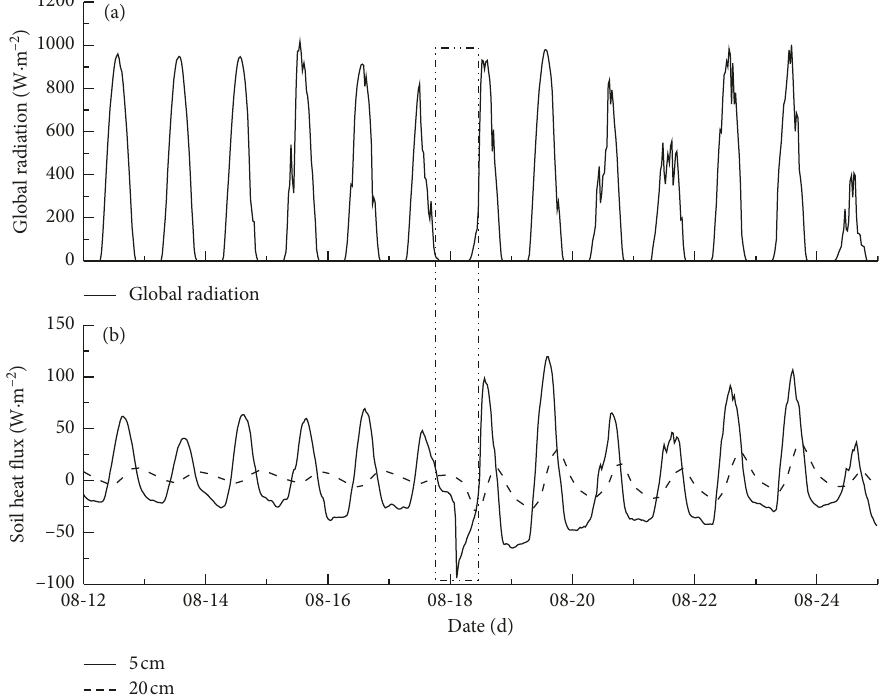
Figure 9: Variations in the (a) global solar radiation and (b) soil heat flux before and after